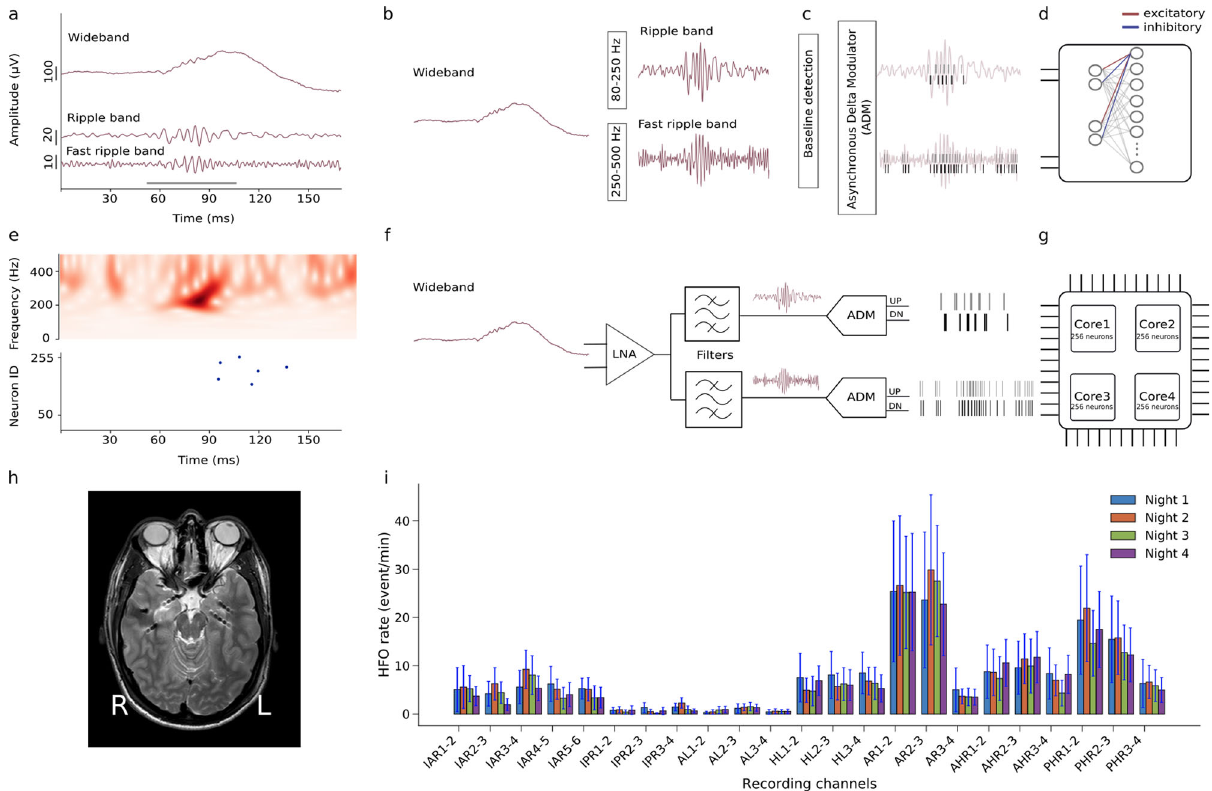
Fig. 1 Automatic HFO detection using a bio-inspired SNN. a The pre-recorded iEEG signal in wideband, Ripple band (80 – 250 Hz) and Fast Ripple band (250 – 500 Hz). HFO stand out of the baseline in the signal. The period marked by the gray bar represents a clinically relevant HFO 27,31 . b – d Software simulated spiking neural network (SNN). For preprocessing, the wideband EEG is fi ltered in Ripple band and Fast Ripple band. A baseline detection stage fi nds the optimum threshold that is applied in an Asynchronous Delta Modulator (ADM) which converts the signal to spikes. Signal traces are encoded by UP spikes (gray bars) and DOWN spikes (black bars), which are then fed as input into the SNN. The SNN is implemented as a two-layer spiking network of integrate and fi re neurons with dynamic synapses. Each neuron in the second layer receives four inputs: two excitatory spike trains from UP channels and two inhibitory ones from DOWN channels. The parameters of the network were chosen to exhibit the relevant temporal dynamics and tune the neurons to produce output spikes in response to input spike train patterns that encode clinically relevant HFO. e , top Time-frequency spectrum of the Fast Ripple iEEG of panel a . e , bottom Firing of SNN neurons indicates the occurrence of the HFO. f Block diagram of the neuromorphic system input headstage. The headstage comprises a low noise ampli fi er (LNA), two con fi gurable bandpass fi lters, and two ADM circuits that convert the analog waveforms into spike trains. g The spikes produced by the ADMs are sent to a multi-core array of silicon neurons that are con fi gured to implement the desired SNN. h MRI with 7 implanted depth electrodes that sample the mesial temporal structures of a patient with drug-resistant temporal lobe epilepsy (Patient 1). i Rates of HFO detected by the neuromorphic SNN for recordings made across four nights for Patient 1. The variability of the HFO rates across intervals within a night is indicated by standard error bars. Recording channels AR1-2 and AR2-3 in the right amygdala showed the highest HFO rates which were stable over nights. Thus, the neuromorphic system would predict that a therapeutic resection, which should include the right amygdala, would achieve seizure freedom. Indeed, a resection including the right amygdala achieved seizure freedom for >1